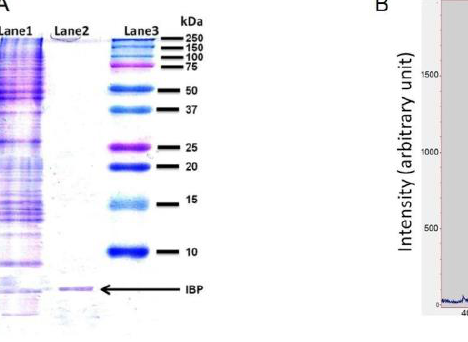
Figure 5. ( A ) Sodium Dodecyl Sulfate-Polyacrylamide Gel Electrophoresis (SDS-PAGE) image of an ice-binding fraction below 10 kDa. Lane 1 shows the crude extra without any purification, lane 2 shows the ice-binding fraction after a two-run of ice-shell purification (IF2), and the lane 3 Precision Plus Protein ™ Dual Color Standards (Bio-Rad) ( B ) mass spectroscopy data shows characteristic peaks as 6.5 kDa, 15.7 kDa and an unknown peak at 11.2 kDa.